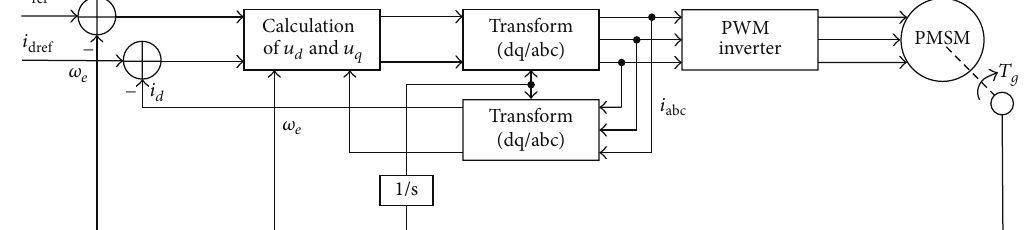
Figure 3: Control block diagram of speed tracking for linearized system.